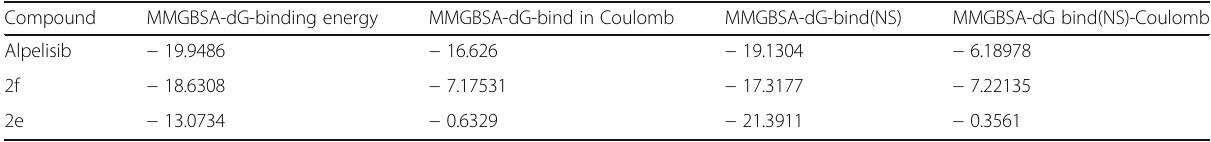
Table 4 The relative binding-free energies (kcal/mol) obtained by Prime MM – GBSA, where MMGBSA dG Bind = Complex − Receptor – Ligand and MMGBSA dG Bind(NS) = Complex − Receptor(from optimized complex) − Ligand(from optimized complex) = MMGBSA dG Bind − Receptor Strain − Ligand Strain. NS in the table is no strain; it is the binding energy without considering for the receptor and ligand conformational changes needed for the formation of complex Compound MMGBSA-dG-binding